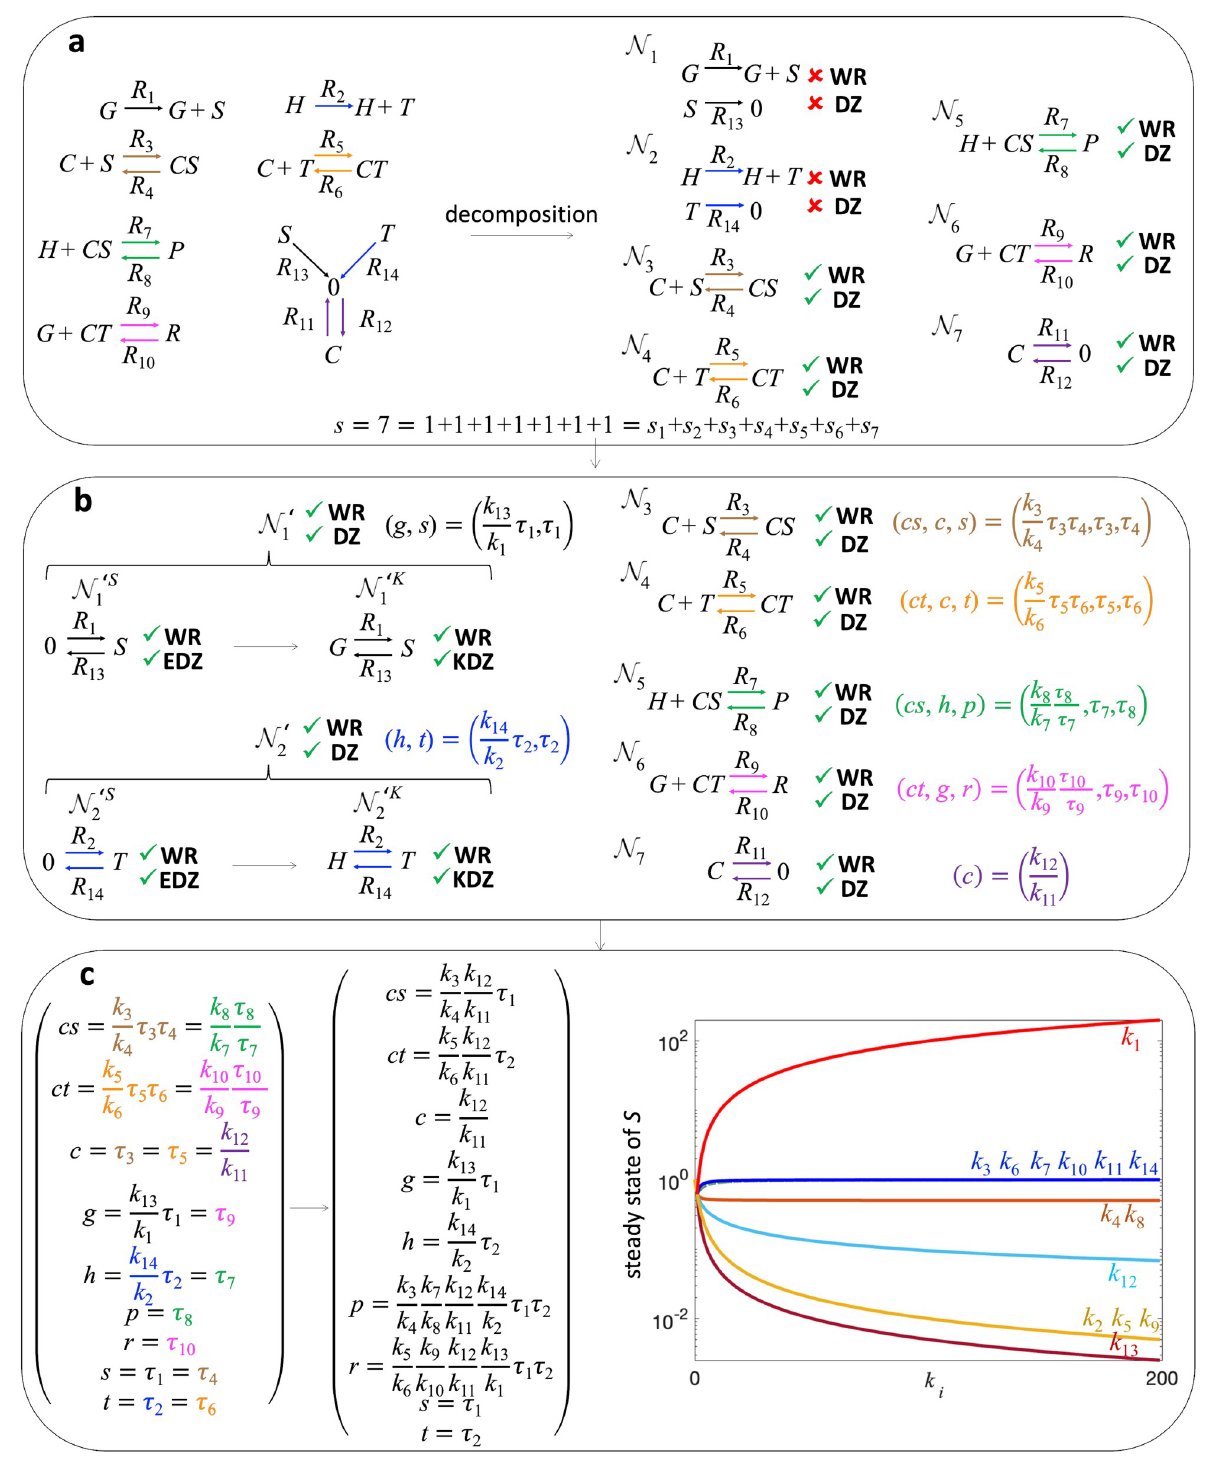
Fig 3. Derivation of analytic steady state of a CRISPRi toggle switch model via network decomposition and network translation. a A CRISPRi toggle switch network (left) that assumes dCas9 with a single guide RNA 1 ( CS complex) and dCas9 with a single guide RNA 2 ( CT complex) bind to a single site on their target genes H and G , respectively. The CRN has nine species (i.e., CS , CT , C , G , H , P , R , S , and T ) and 14 reactions (i.e., R 1 , ... , R 14 ), which is decomposed into seven independent subnetworks ( N 1 ; ... ; N 7 ) (right). b As the subnetworks N 1 and N 2 are not WR and DZ, network translation is performed. The translated subnetworks ( N 0 and N 0 ) are WR and DZ (i.e., both its stoichiometric and kinetic-order CRNs are 1 2